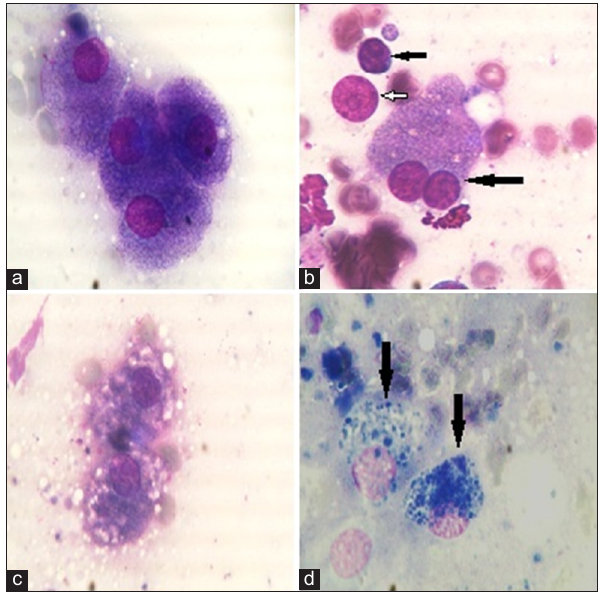
Figure-4: Cytological findings in all groups: (a) Normal hepatocytes of control healthy group. Cells contain centrally located nuclei with basophilic cytoplasm and a single prominent pale-blue nucleolus (arrow) (field stain 1000×). (b) Hepatic smears of acute hepatitis group. Binucleated hepatocytes (long arrow) with the presence of lymphocyte (short arrow), naked (free) nuclei with prominent nucleoli (white arrow) (field stain 1000×). (c) Moderate vacuolar changes in hepatocytes of acute hepatitis group (field stain 1000×). (d) Two hepatocytes with accumulation of bile pigment (arrow) (field stain 1000×).